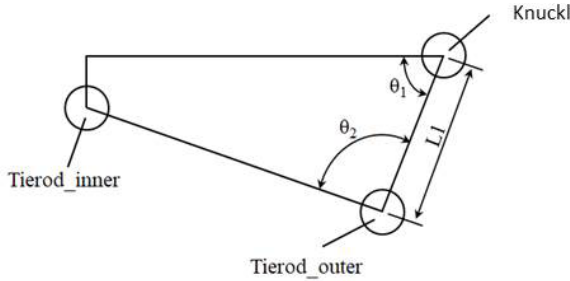
Figure 12. Top view of one-sided steering